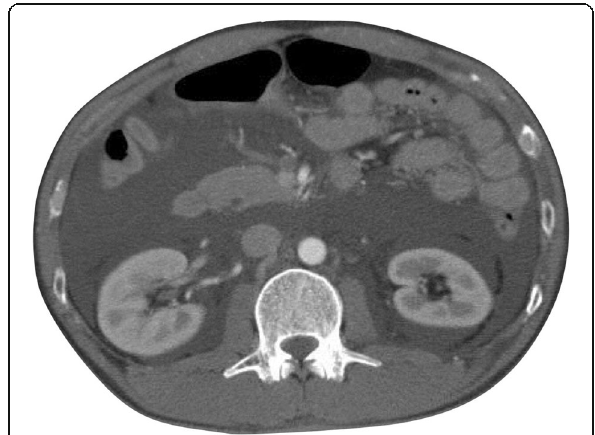
Fig. 3 Postoperative abdominal CT revealed fluid accumulation in the peritoneal cavity and